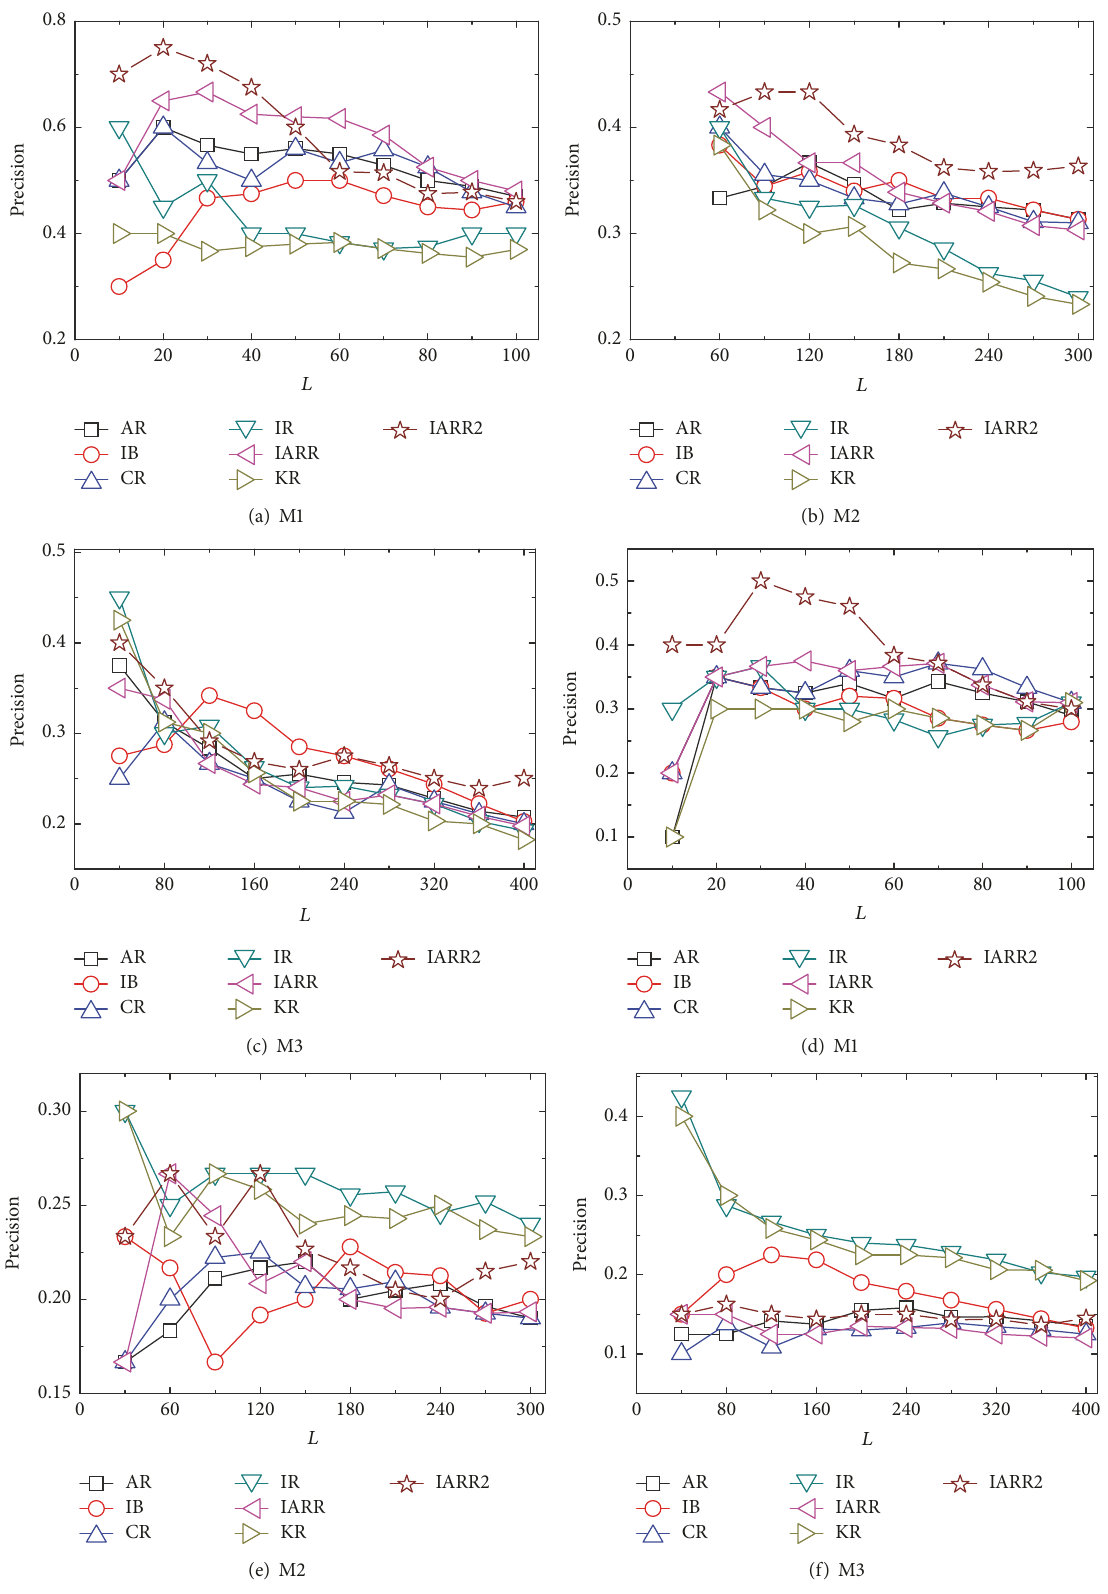
Figure 4: Algorithmic accuracy for identifying good movies measured by 𝑝𝑟𝑒𝑐𝑖𝑠𝑖𝑜𝑛 . Due to the different size of the three datasets, we set the maximum 𝐿 equal to 100 , 300 , and 400 for M1, M2, and M3, respectively. (a)–(c) Results found by evaluation with the Academy Awards benchmarks, (d)–(f) results found by evaluation with the Golden Globe Awards